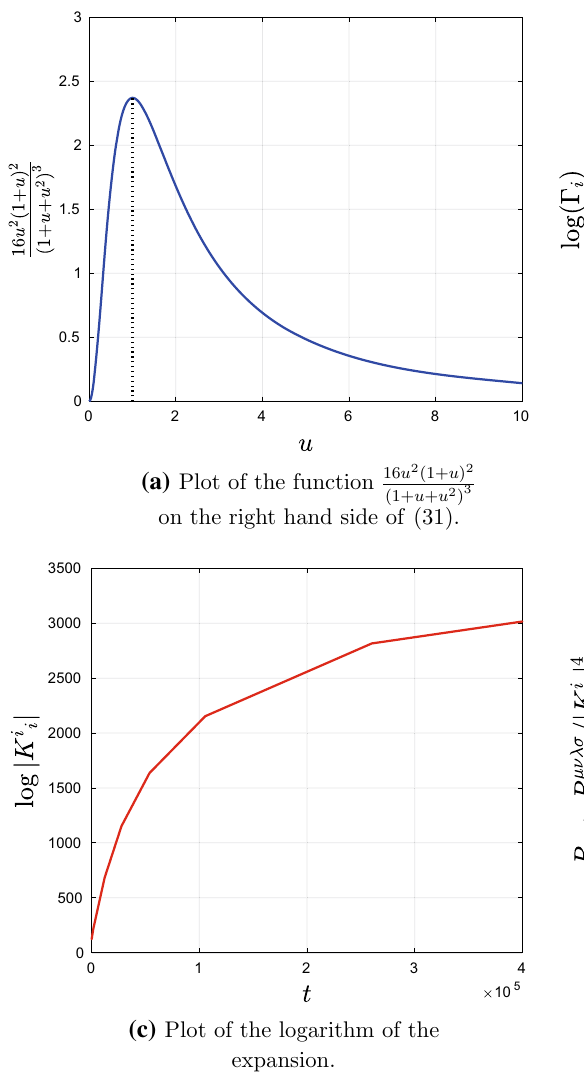
( d ) Plot of the Hubble normalized Kretschmann